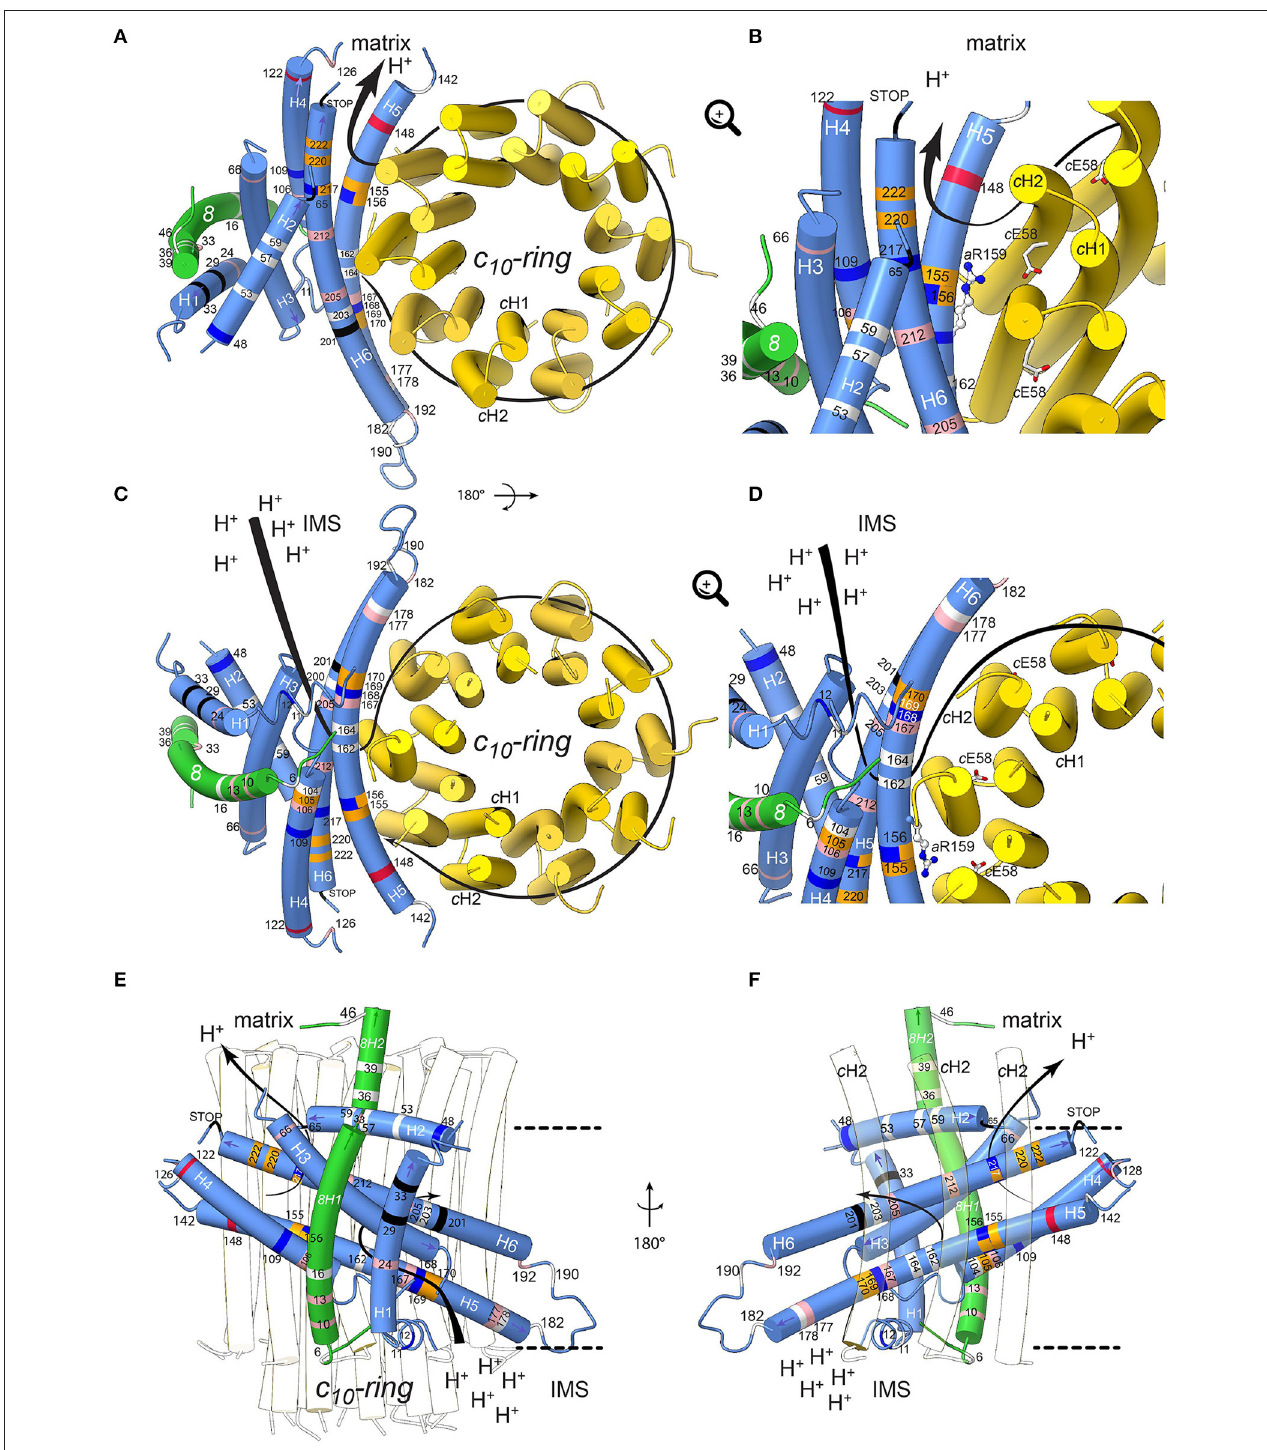
FIGURE 4 | Positions of human neurodegenerative disease-causing mutations in the structure of the yeast mitochondrial ATP synthase subunits a and 8 (human A6L ). The views are from the matrix (A,B) and from the IMS (C,D) with detailed views in the IMS entry channel (B) and in the matrix exit channel (D) . On (E,F) , showing views along the membrane plane from outside the F o stator and from the c -ring, respectively, the membrane borders are indicated as black lines. Subunits a , 8, and c are shown in blue, green, and yellow, respectively. The model is based on structural data from the Y. lipolytica and S. cerevisiae structures (Hahn et al., 2016; Guo et al., 2017). The positions of mutations, which have been found in human neurodegenerative diseases, are marked in white, red, blue, pink, orange and black for